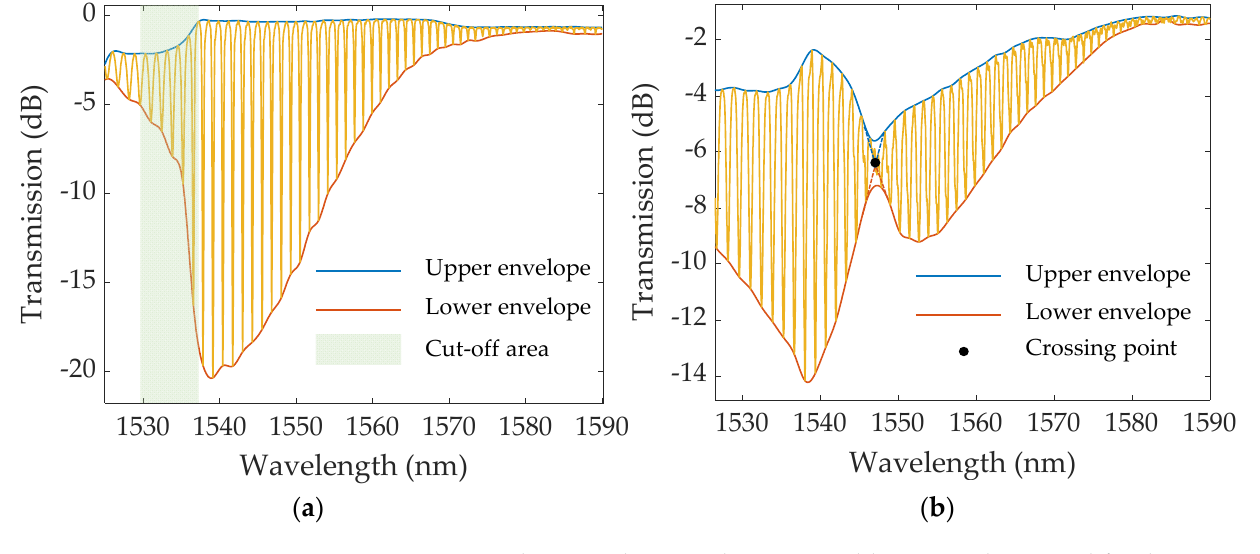
Figure 4. Transmitted spectra denoting the upper and lower envelopes used for the respective methods of analysis for ( a ) the bare TFBG and ( b ) the Au–TFBG.